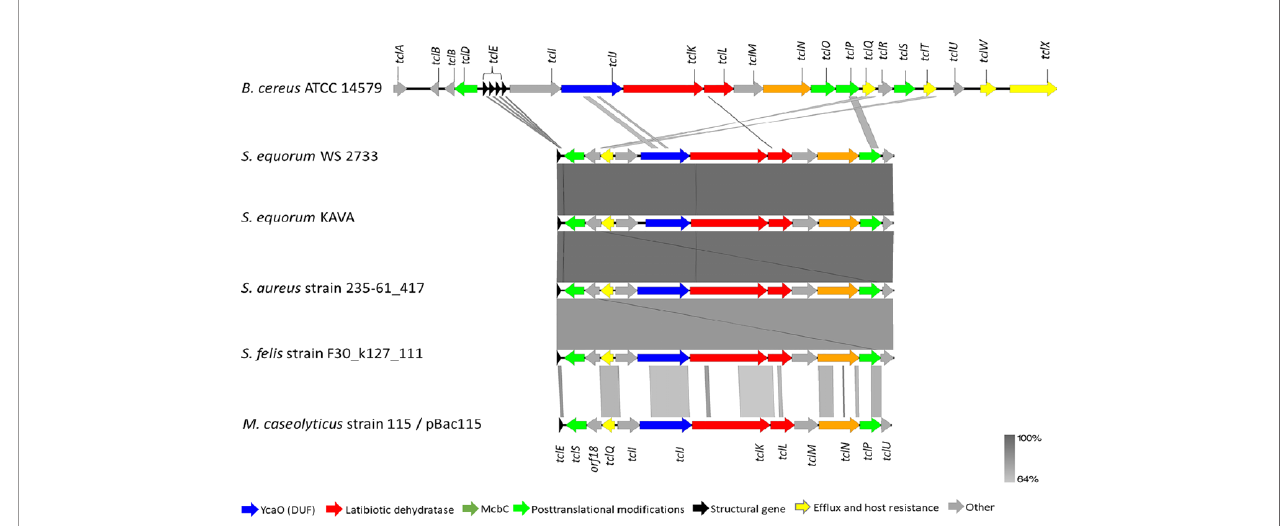
FIGURE 2 | Genetic organization of micrococcin P1 gene cluster of S. equorum WS 2733 and S. equorum KAVA in comparison with reference gene cluster in the plasmid pBac115 of M. caseolyticus (accession number: KM613043), S. aureus strain UP 1591 plasmid unnamed (GenBank accession: CP047810), S. aureus strain 235-61_417 plasmid unnamed (GenBank accession: VUGU01000042.1) and S . felis strain F30_k127_111 (GenBank accession:QKYH01000057). The open reading frames that are involved in micrococcin P1 production are shown in different colors. Areas shaded in grey indicate homologous regions with 69-100% nucleotide